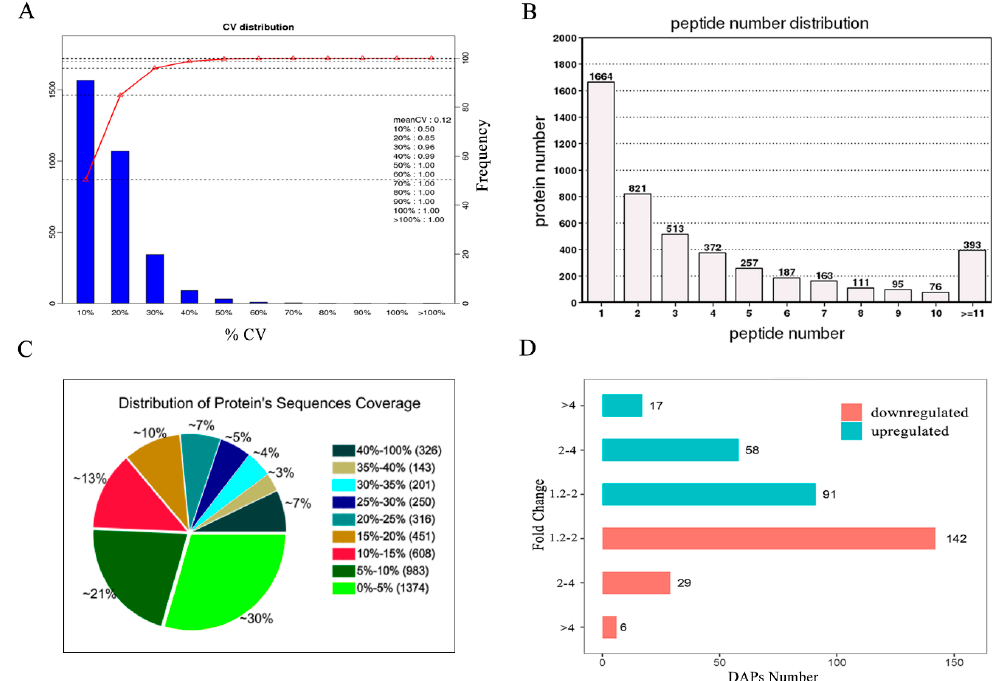
Figure 2. ( A ) The repeatability of the three protein abundance ratios (HBF / NBF). The x-axis represents % CV of the three ratios. The left vertical axis represents the number of proteins. The right vertical axis represents the cumulative % of the counted proteins (red line). ( B ) The peptide number distribution. ( C ) The distribution of protein’s sequences coverage. ( D ) The number of proteins identified up and down-regulated between the HBF and NBF placentas.